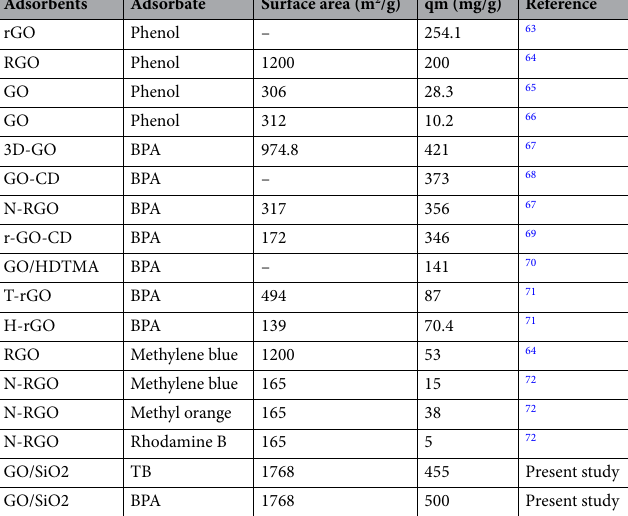
Table 5. Comparable investigation onto the different types of graphene oxide